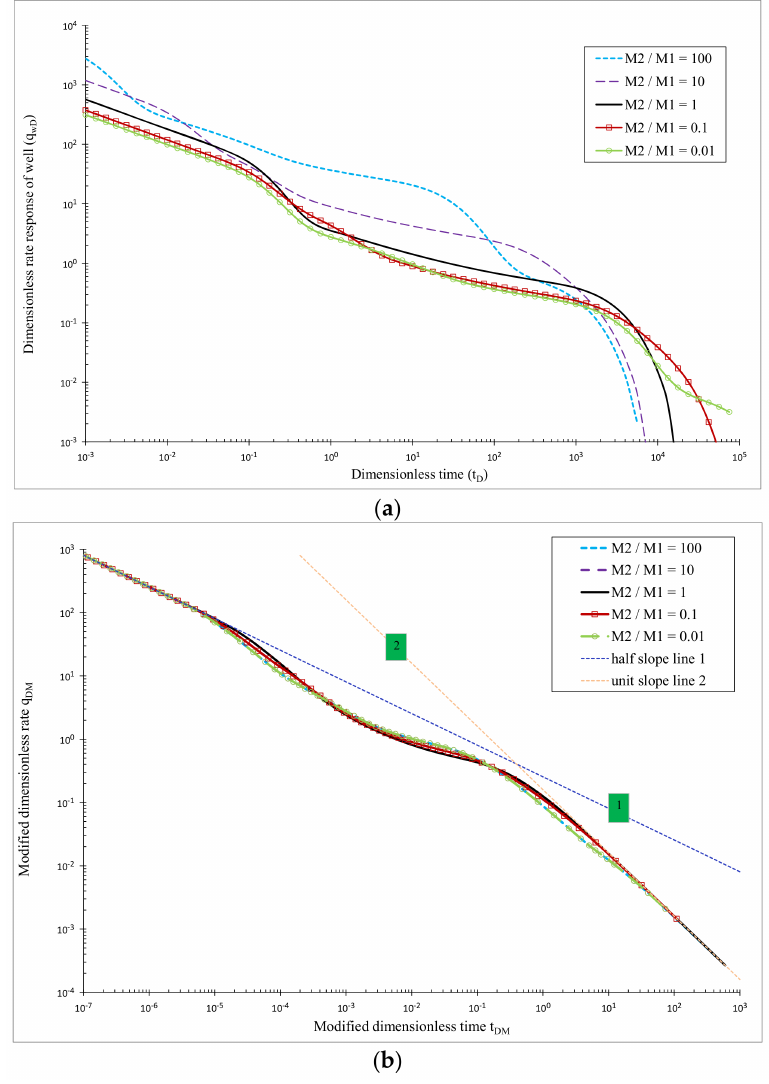
Figure 10. ( a ) Dimensionless rate q wD vs. dimensionless time t D and ( b ) modified dimensionless rate q DM vs. modified dimensionless time t DM , under various M 2 /M 1 ratios, with 2 L f 1 D h f 1 D = h f 2 D = 5, N stage = 10; x e 1 D = x e 2 D = 100, y e 1 D = y e 2 D = 100, h e 1 D = h e 2 D = 50 and C s2 /C s1 =